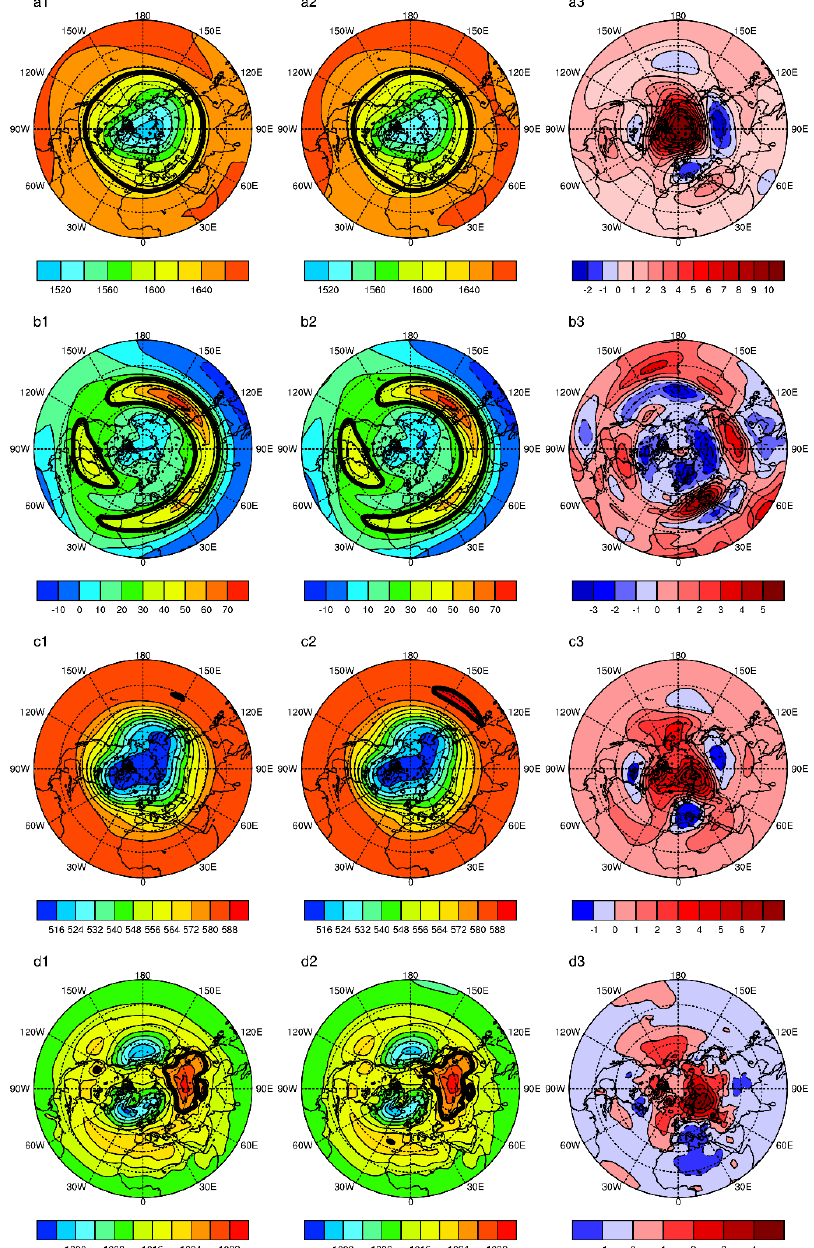
Figure 3. The distribution of geopotential heights at 100 hPa (( a1 , a2 ), units: dagpm), zonal winds at 200 hPa (( b1 , b2 ), units: m · s − 1 ), geopotential heights at 500 hPa (( c1 , c2 ), units: dagpm), sea level pressure (( d1 , d2 ), units: hPa) during the P1 and P2 periods and their differences between the two periods (P2–P1, ( a3 , b3 , c3 , d3 )). (The bold solid black lines in Figure ( a1 , a2 ) represent the 1628 dapgm geopotential heights. The bold solid black lines in Figure ( b1 , b2 ) represent the 30 m · s − 1 . The bold solid black lines in Figure ( c1 , c2 ) represent the 588 dapgm geopotential heights. The bold solid black lines in Figure ( d1 , d2 ) represent the 1023 hPa. The dotted areas represent the differences which pass the significance test of 90%. The outermost latitude is 0 ◦